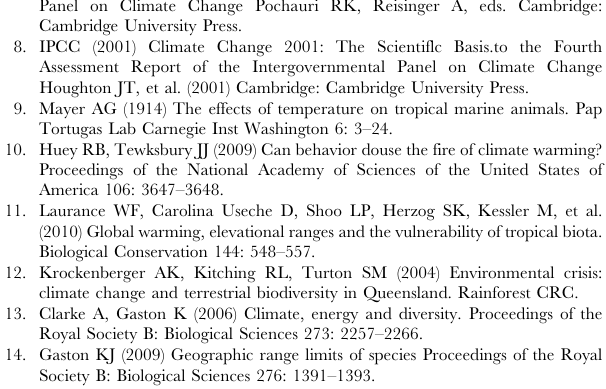
Table S1 Mean UTLs of 34 species from different habitats under four heating regimes VST, ST, MT and LT (see methods): 11 UIT spp., 11 LIT spp. and 12 SubT spp. The types of tactile and/or behavioural stimuli performed on each species to determine their response are listed below with (1)- Body movement and muscle contraction, (2)- Siphon reaction, (3)- Ability to hold the shell closed, (4)- Tube-feet or arms/spines movement, (5)- Response of the mouth and cirri, (6)- Response of legs and mouthparts. Table S2 Model comparisons with and without inclusion of species. Inclusion of taxonomic signal significantly improved the model, as indicated by a likelihood ratio greater than one. AIC = Akaike’s information criterion ; df = degrees of freedom. Table S3 Multimodel inference produced model-averaged parameter estimates and unconditional errors based on AICc for all variables included in the full linear mixed effects (lme) model: upper lethal temperature (ULT) as a function of three fixed factors: log(experimental rate of temperature change), habitat (subtidal, littoral, upper intertidal), and activity quotient. First and second order terms were included in the full model based on a priori hypotheses. Treatment coefficients contrast each variable level with the reference level (subtidal). Effect types are intercept (unshaded) and slope (shaded). Starred parameters indicate contrast coefficients with 95% confidence intervals greater than 0. The minimum adequate model results and % variance explained by the random effect of ‘‘Species’’ are in Table